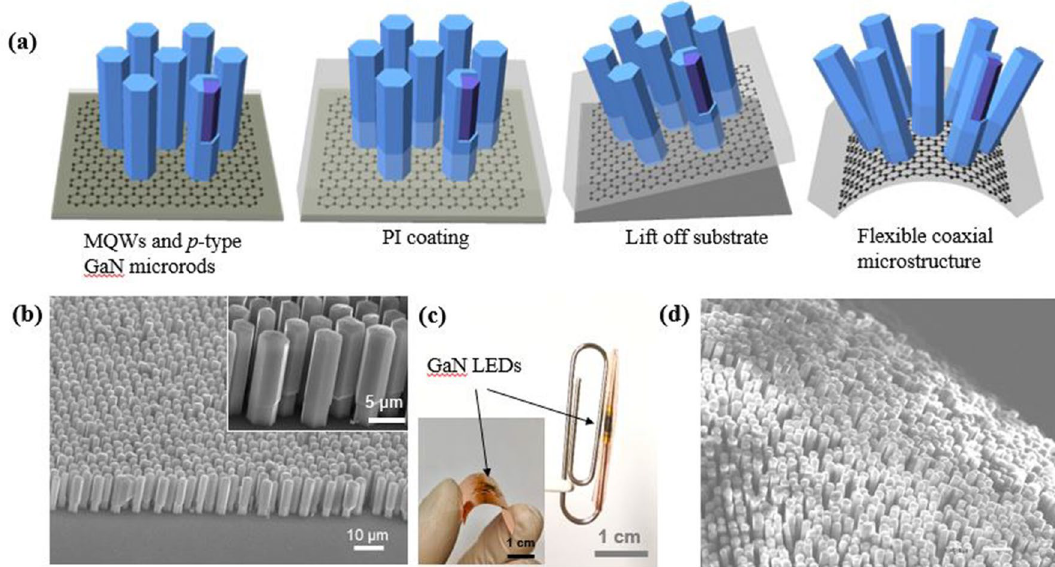
Figure 4. Position-controlled growth of micro-LEDs and flexible properties. ( a ) Schematic illustration of GaN microrods growth on graphene films. ( b ) SEM image of micro-LEDs. ( c ) Optical image of bending LEDs on paper clip. The inset in ( c ) shows the GaN microrods are bent by hand. ( d ) Bent SEM image of micro-LEDs.